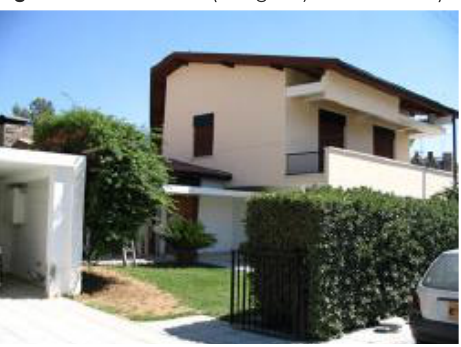
Figure 25. Efrus House (Image by Author, 2016)